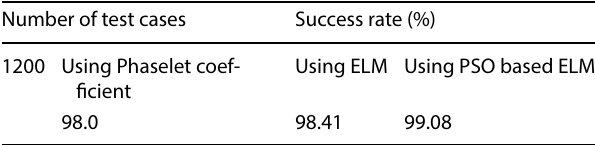
Table 13 Performance comparison Number of test cases